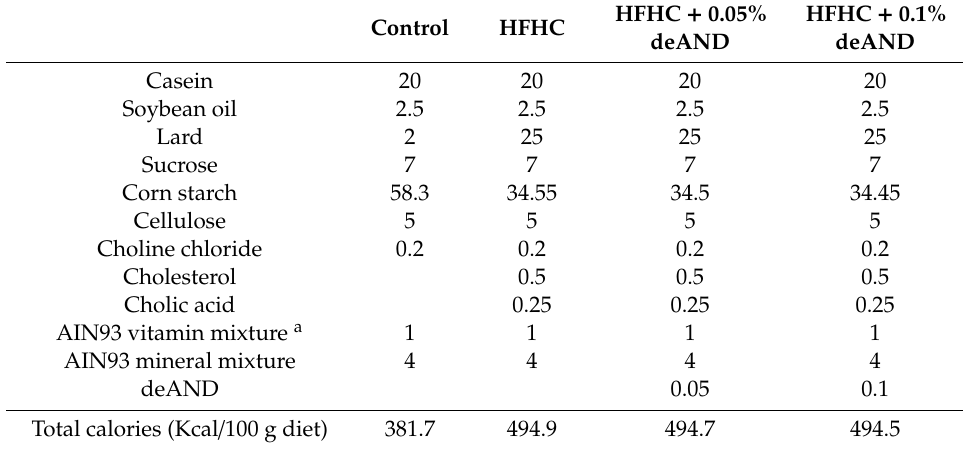
Table 1. Compositions of the experimental diets a